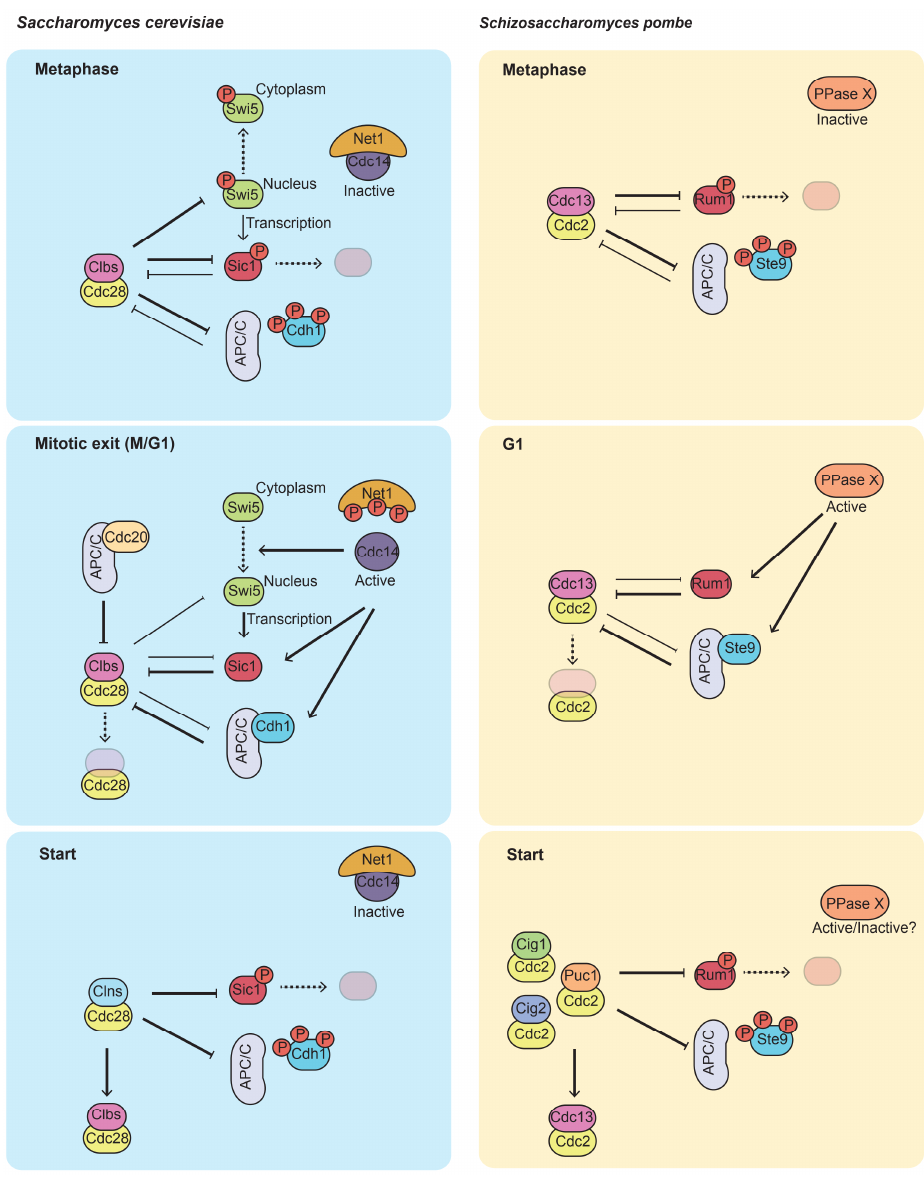
Figure 1. Phosphatases in the regulation of cyclin-dependent kinase (CDK) activity during G1. Left panel (budding yeast): During metaphase, high CDK activity destabilizes the CKI Sic1, prevents its transcription by Swi5 and precludes activation of the anaphase promoting complex / cyclosome (APC / C) by Cdh1. At mitotic exit, release of Cdc14 from the nucleolus, together with a decline in CDK activity leads to the accumulation of Sic1 and the activation of the APC / C Cdh1 . Sic1 and Cdh1 sustain a state of low CDK activity during pre-Start G1 (even though Cdc14 has returned to the nucleolus). At the Start transition, the rising activity of G1 CDK complexes (which are insensitive to Sic1 and APC / C Cdh1 ) results in the degradation and inactivation of Sic1 and APC / C Cdh1 , respectively. Right panel (fission yeast): During mitosis, high CDK activity leads to the degradation of Rum1 and prevents the binding of Ste9 to the core APC. During conditions that require a prolongation of G1 (e.g., during growth on poor nitrogen sources), Rum1 and Ste9 become dephosphorylated by an unknown phosphatase and active. This activation is reversed by G1 / S-CDK complexes at the Start transition.